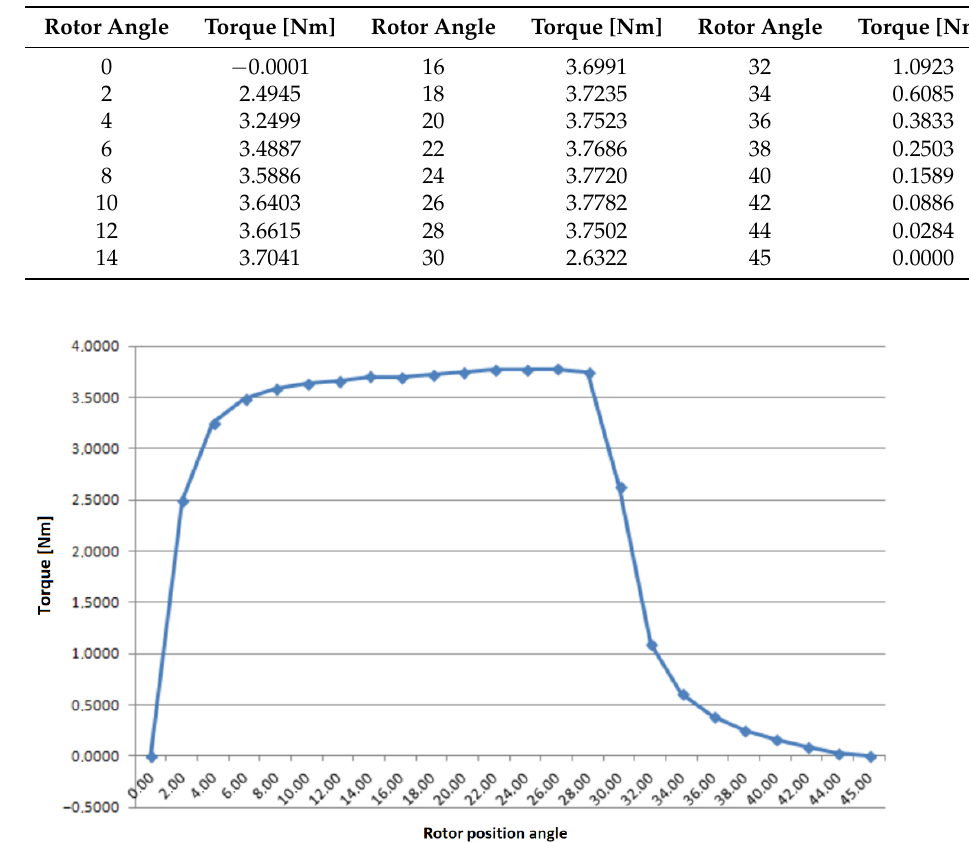
Figure 15. Torque characteristic of the modeled SRM 6/4 motor. The characteristics are based on data from Table 2.